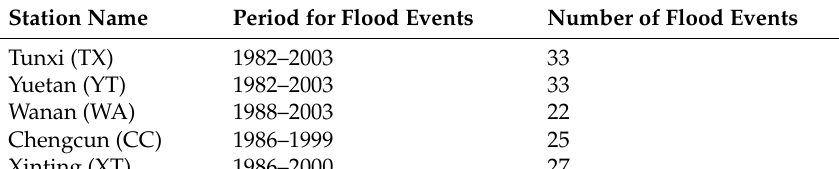
Figure 4. Land cover type maps for Tunxi catchment.